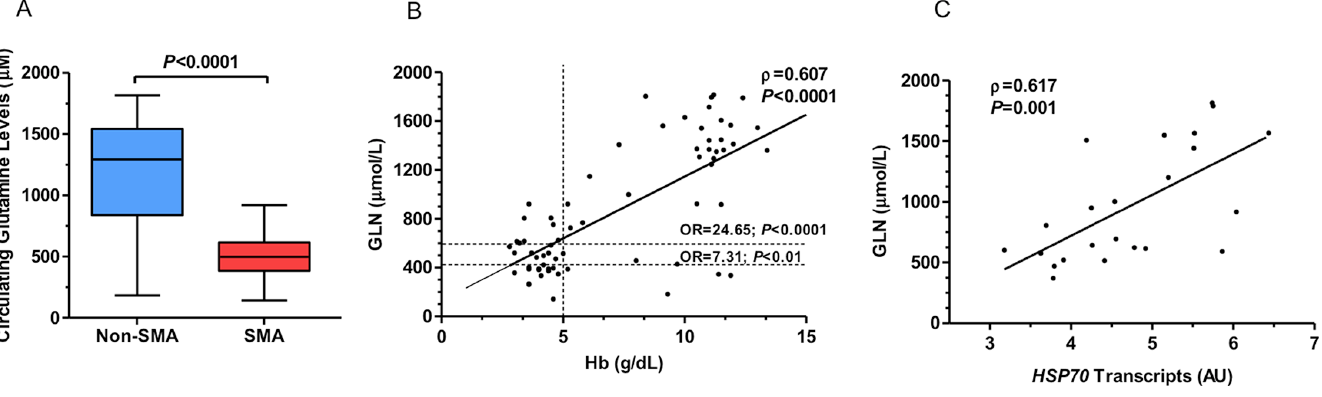
Figure 5. Circulating glutamine levels and HSP70 transcripts in children with malaria. (A) Glutamine plasma concentrations (mmol/L) in children stratified into non-SMA (Hb ≥ 5.0 g/dL, n = 37) and SMA (Hb <5.0 g/dL, n = 31). Box plots depict the data, where the box represents the interquartile range, the line through the box is the median, and whiskers illustrate the 10th and 90th percentiles. Significance deter- mined by Mann-Whitney U test. (B) Relationship between circulating glutamine (GLN) and hemoglobin (Hb) levels (g/dL) determined using Spearman ′ s rank correlation test. Also shown are lines indicating cutoff values for SMA (Hb <5.0 g/dL) relative to GLN levels above and below 420 mmol/L ( <420, n = 20 and >420, n = 48), and referenced according to 2STD below the mean (<598 mmol/L, n = 29 and >598, n = 39). Logistic regression analyses were used to determine the relationship between the GLN cutoff values and susceptibility to SMA. (C) Relationship between plasma GLN and HSP70 transcripts levels (n = 33) was determine by Spearman ′ s rank correlation